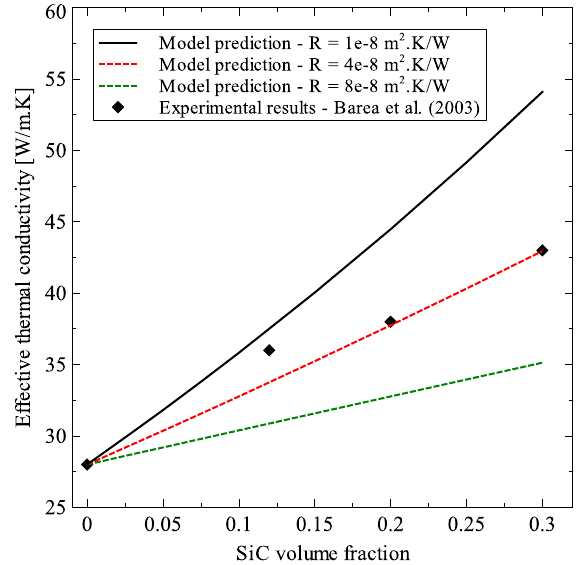
Figure 10. Comparison of model predictions with experimental results for Al 2 O 3 –SiC composite [33].